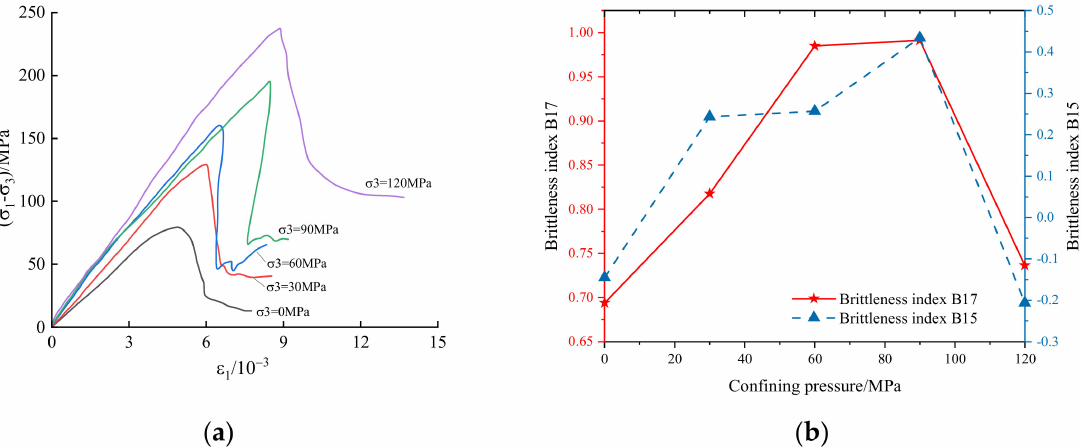
Figure 7. Calculation of stress–strain curve and brittleness index of shale. Note: ( a ) and ( b ) represent the variation law of the shale stress–strain curve and brittleness index with confining pressure,